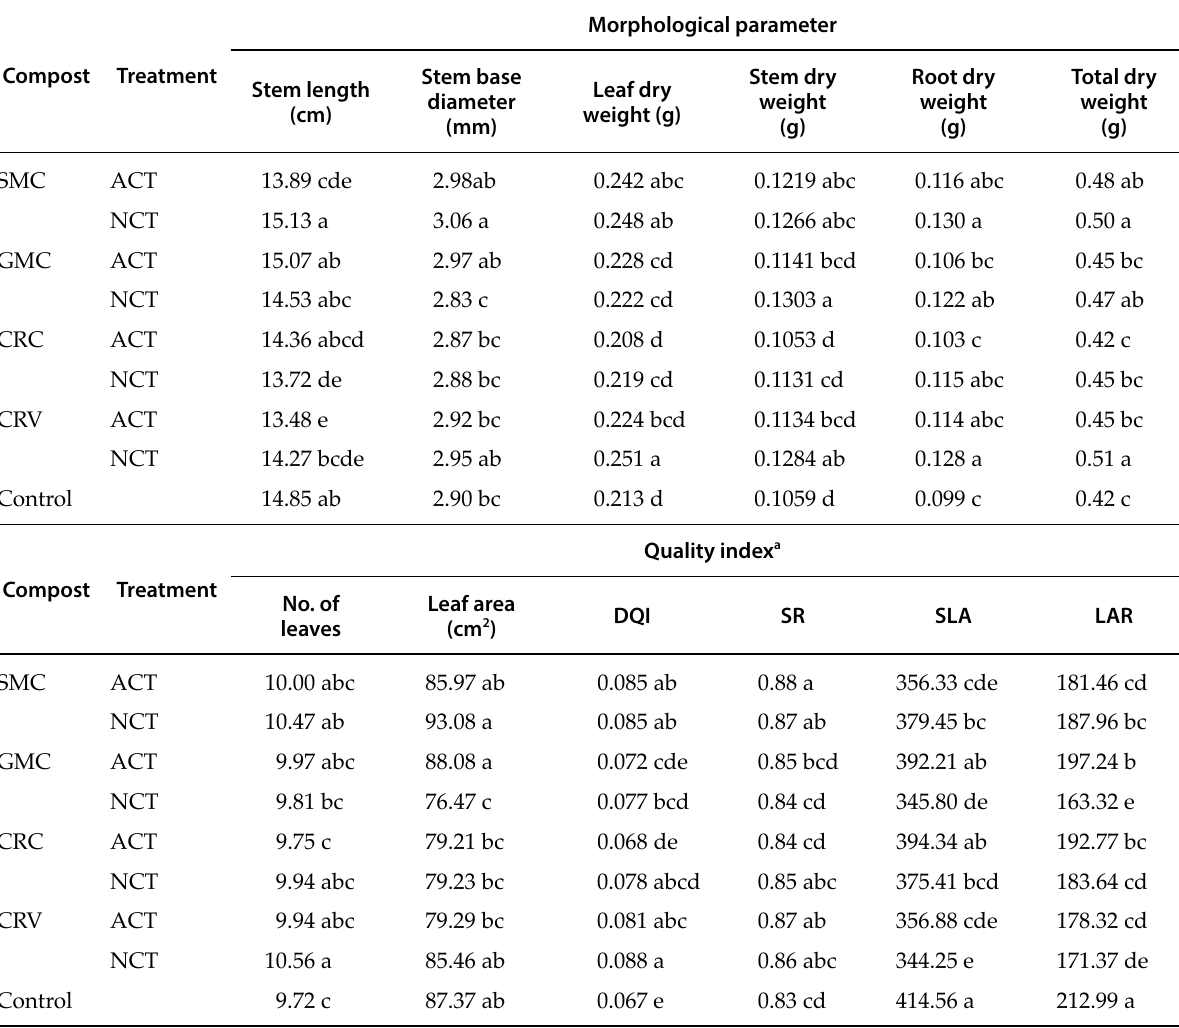
Table 1. Morphological parameters and quality indices of pepper plants treated with aerated compost tea (ACT) and non- aerated compost tea (NCT) from spent mushroom compost (SMC), grape marc compost (GMC), crop residues compost (CRC) and crop residues vermicompost (CRV). Applied compost teas were obtained in ratio 1:4 w:v. Different letters indicate significant differences according to ONE-WAY-ANOVA test ( P = 0.05). Bold values are significantly greater than the